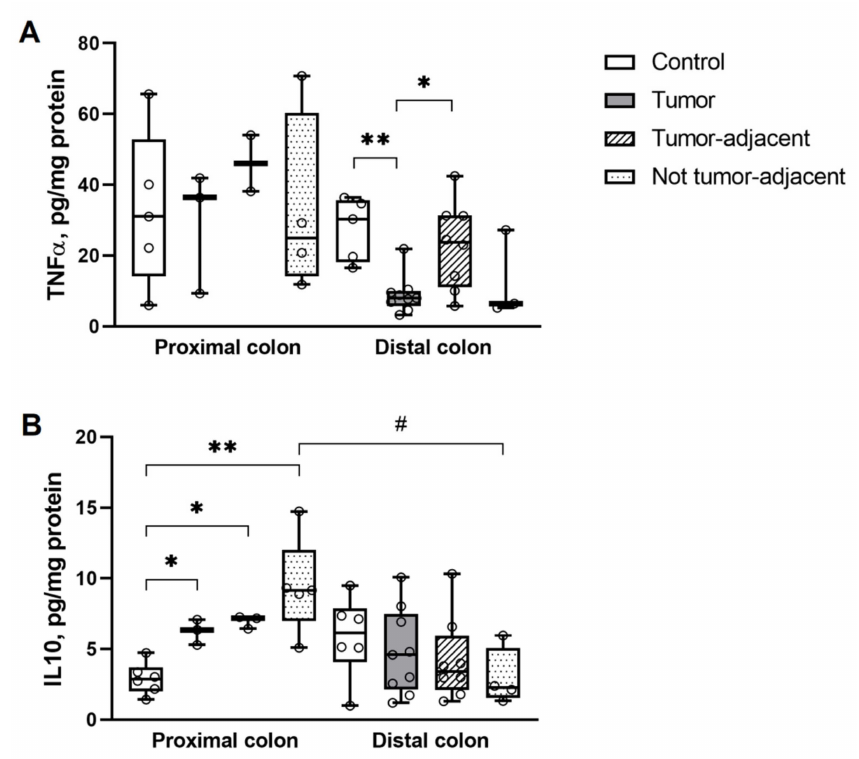
Figure 1. Elisa kit analysis of ( A ) TNF α and ( B ) IL10 in tumor, tumor-adjacent and non- tumor segments in the proximal and distal parts of the colon in DMH-rats. * p < 0.05, ** p < 0.005, # p < 0.05, Mann–Whitney U-test. The number of symbols corresponds to the number of samples.